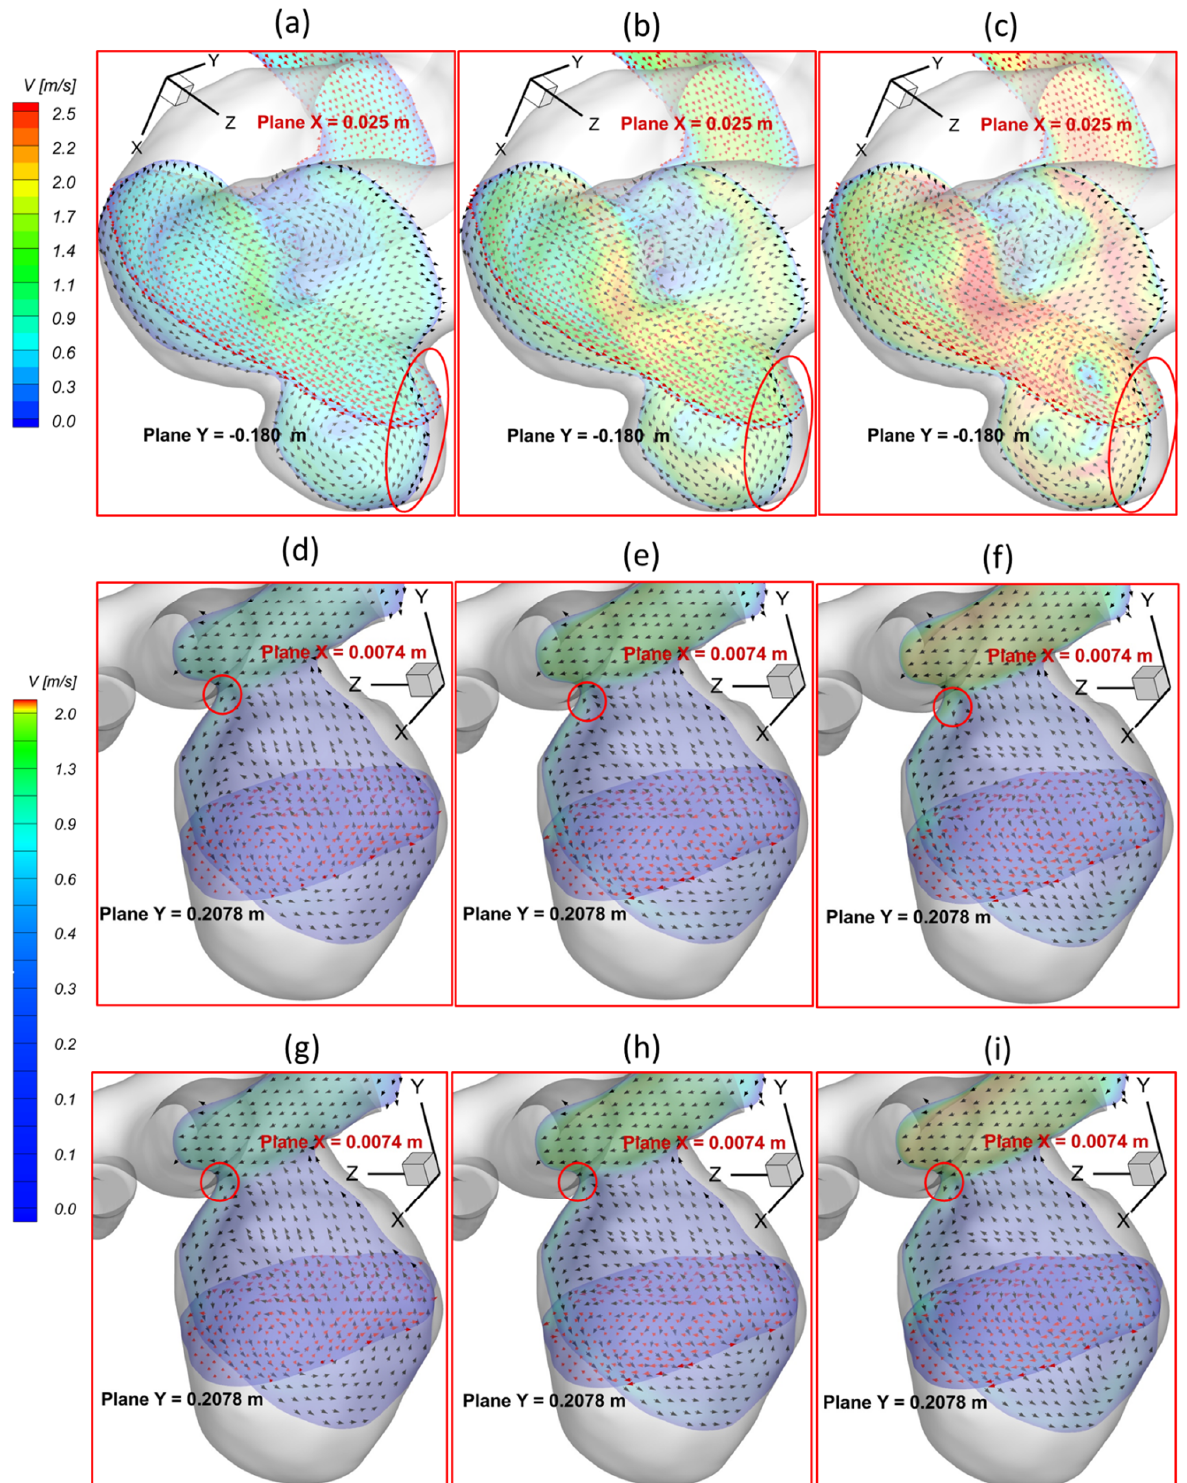
Figure 10. Visualized velocity profiles at t 2 = 0.22 s in extracted planes of ICASA models: ( a ) ICASA−1, q A1 :q A2 = 75:25, and PFR−I, ( b ) ICASA−1, q A1 :q A2 = 75:25, and PFR−II, ( c ) ICASA−1, q A1 :q A2 = 75:25, and PFR−III, ( d ) ICASA−2, q A1 :q A2 = 75:25, and PFR−I, ( e ) ICASA−2, q A1 :q A2 = 75:25, and PFR−II, ( f ) ICASA−2, q A1 :q A2 = 75:25, and PFR−III, ( g ) ICASA−2, q A1 :q A2 = 64:36, and PFR−I, ( h ) ICASA−2, q A1 :q A2 = 64:36, and PFR−II, and ( i ) ICASA−2, q A1 :q A2 = 64:36, and PFR−III.